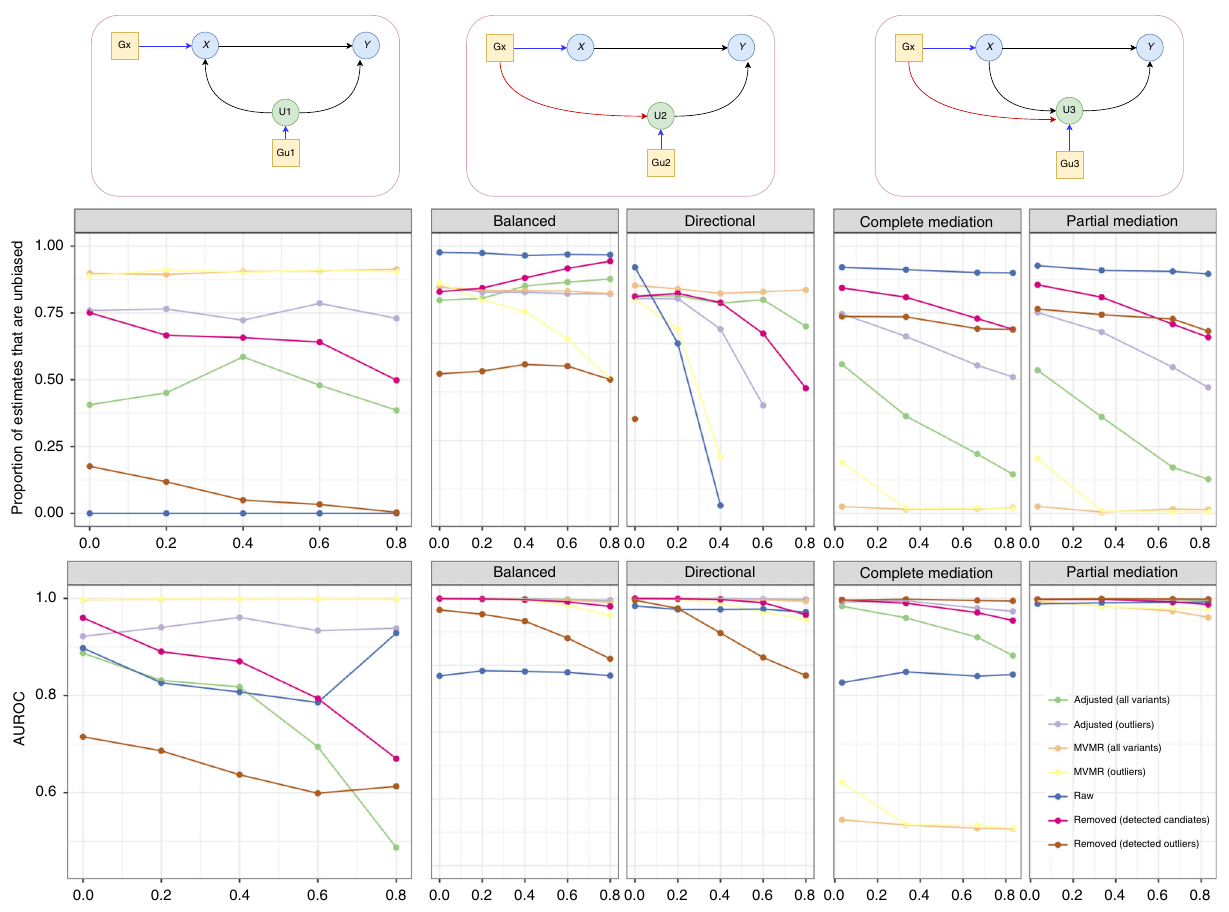
Fig. 2 Simulations comparing methods across different scenarios. We evaluated three scenarios: confounding pleiotropy, horizontal pleiotropy and mediated pleiotropy (columns of graphs, with DAGs illustrating the scenarios. See Methods for full details). The x- axis of each graph represents the proportion of variants used to instrument x that were similated to exhibit pleiotropic effects. Typically, 30 instruments were simulated directly for x but this varies across scenarios where necessary. The y- axis of the fi rst row of graphs represents the proportion of simulations that lead to unbiased effect estimates of x on y. The y- axis of the second row of graphs represents the sensitivity and speci fi city of the analysis across the simulations, where the area under the receiving operating curve (AUROC) represents the ability of the method to distinguish between simulations in which the causal effect of x on y is either null or not null. For all graphs, higher y- axis values are better. Seven methods are evaluated at each simulation. Raw = IVW random effects estimates applied to all detected instruments; Removed = either all outliers are removed, or only outliers detected to associate with a candidate trait; MVMR = multivariable MR using either candidate traits detected to associate with any instrument or using only candidate traits associated with outlier instruments; Adjusted = adjusting SNP – outcome associations for candidate traits applied either only to variants detected to be outliers, or all variants regardless of outlier